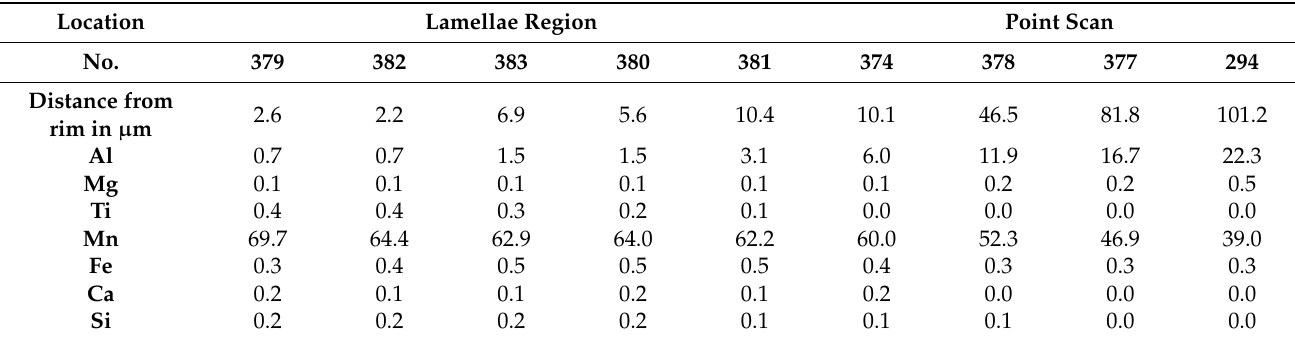
Table 3. Elemental concentrations (wt.%) at the locations depicted in Figure 5, sorted in ascending order according to the Al concentration. For a close-up of the lamellae region, see Appendix C. The distance from the lamellae region points to the nearest rim is given. Regarding the point scans, a virtual line is drawn through all points to the left rim. The distances are given from each point to the intersection of this line with the rim.